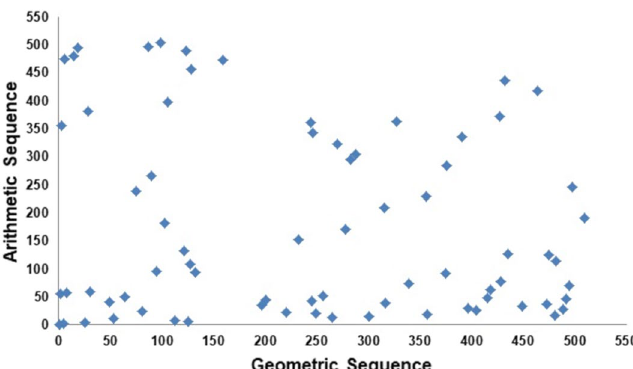
Fig. 3 Euclidean space points—for 512 key =